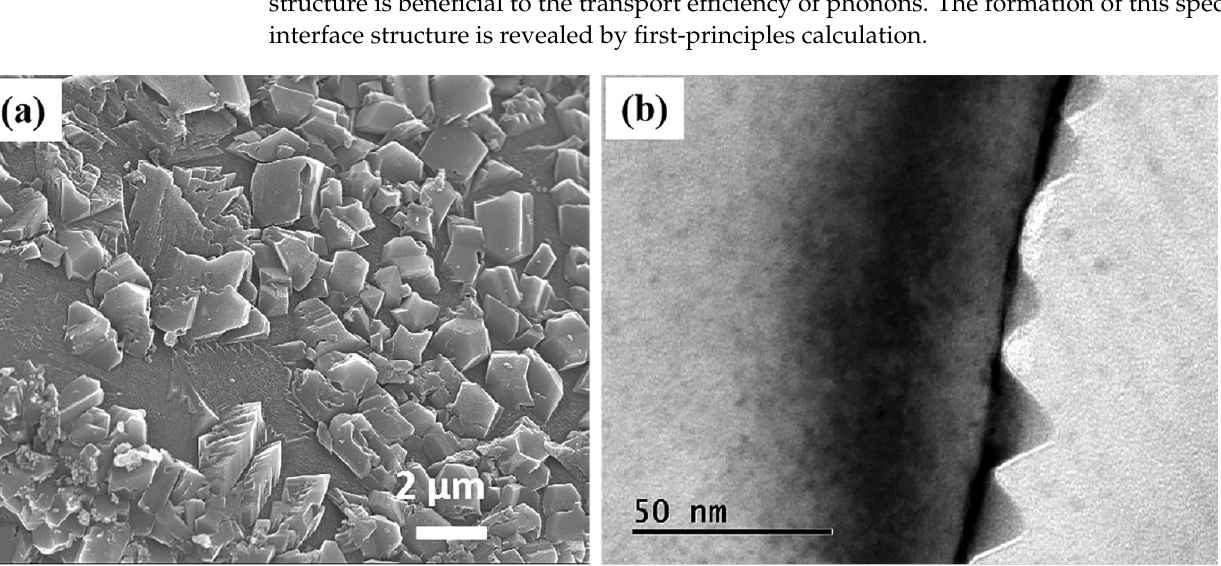
5 of 12 Figure 2. SEM images for the fractured surfaces of: ( a ) diamond/Cu; ( b ) diamond/Cu-B composites with 0.5 wt.% boron; ( c ) diamond/Cu-B composites with 1.0 wt.% boron; ( d ) polished surface of diamond/Cu-B composites ( b ); ( e ) element analysis of interface area in ( d ); and ( f ) XRD patterns of diamond/Cu-B composites ( b ). For diamond/Cu-B composites, the phase compositions of the polished surfaces (Fig-